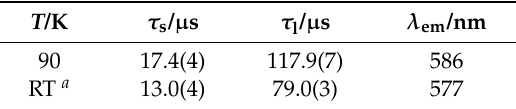
Table 5. Selected distances and angles for Cu 4 : in ground state ( S (cid:2868) ): comparison of experiment and theory. 90 K denotes experimental results (Table 1); QM/MM denotes modelled solid-state structures; CAM-B3LYP denotes theoretical isolated-molecule results (shown only once for molecule A entries).